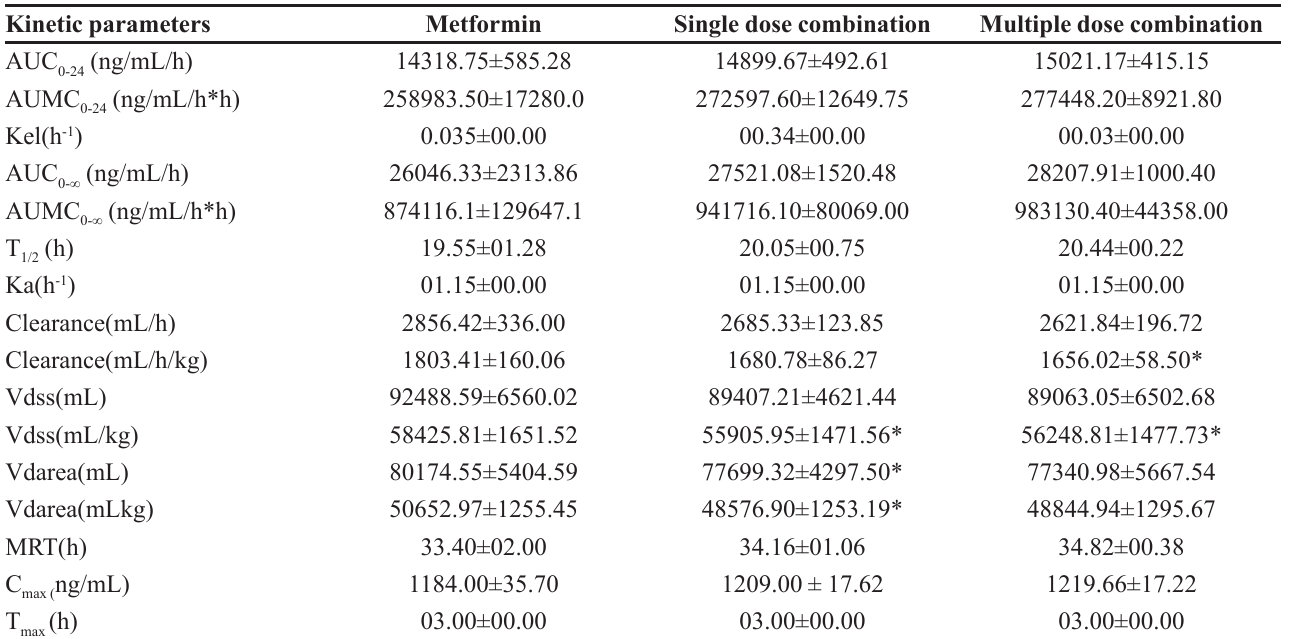
TABLE VI - Pharmacokinetic parameters after administration of metformin 70 mg/1.5 kg body weight, disopyramide 14 mg/1.5 kg body weight, single dose and metformin, disopyramide multiple dose and metformin in normal rabbits